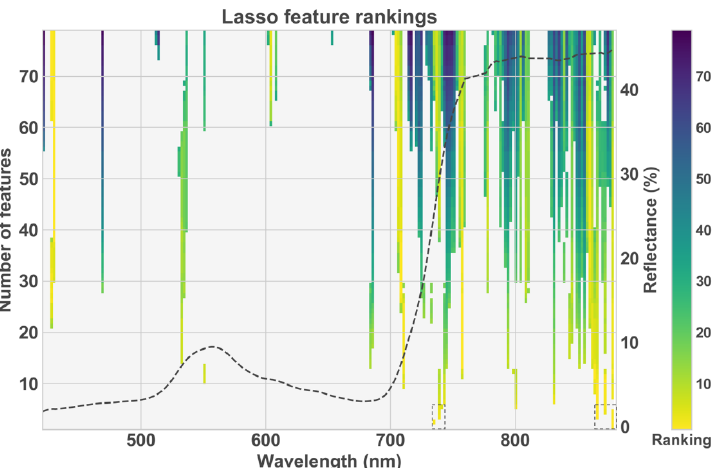
Figure 5. Hyperspectral features selected by the Lasso algorithm (the colored areas indicate selected features). The color indicates the ranking of the feature coefficients determined by the regularization term (yellow color corresponds to a ranking with higher feature coefficients). The top five features from 735 to 744 nm and from 867 to 879 nm are outlined to emphasize the most significant spectral regions for NUP. The mean hyperspectral reflectance across all segmented images used in this study (i.e., mean vegetation) is overlaid for reference.